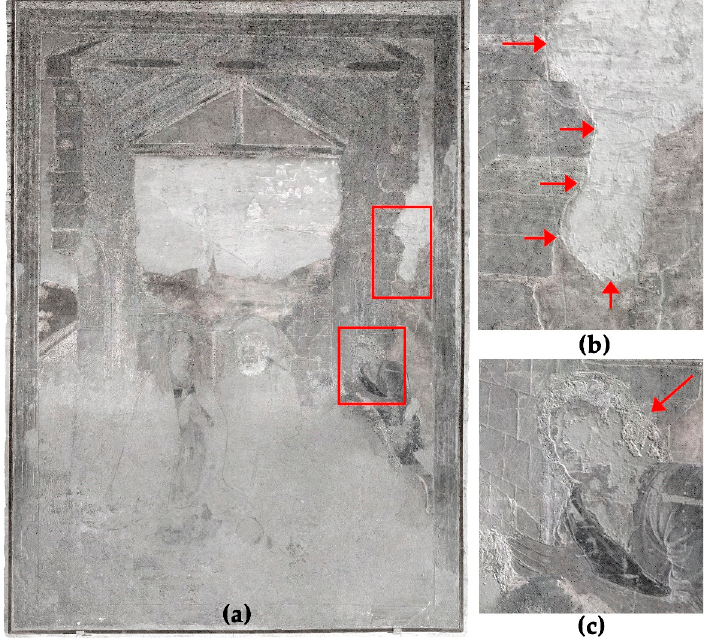
Figure 10. ( a ) NDPI image based on the UV-R _UV and the IR-R _IR spectral images. ( b ) Detail showing the plaster borders between two giornata . ( c ) Detail highlighting the differentiation of intact and lost